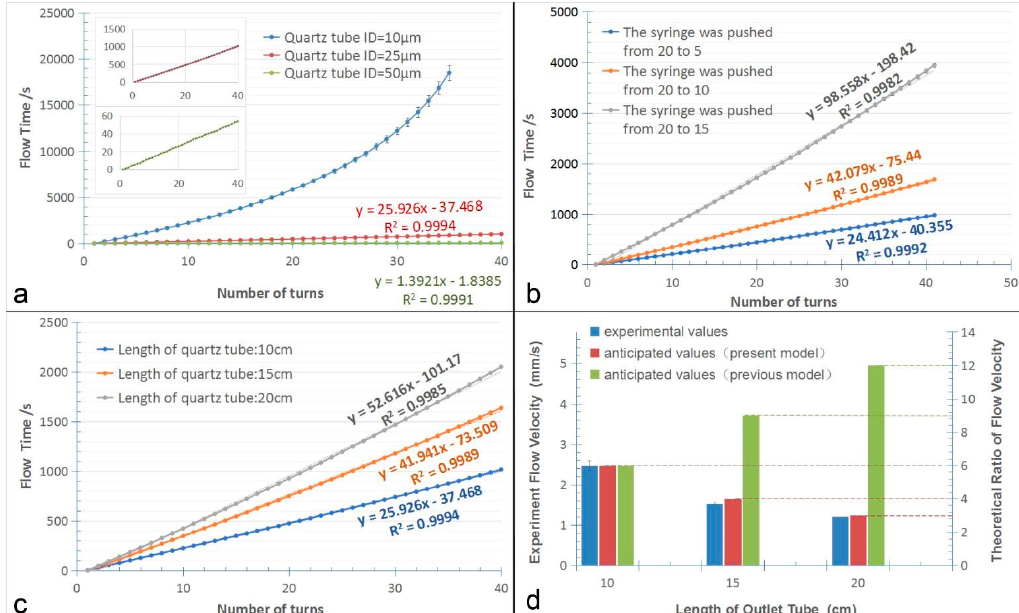
Figure 5. The self-activated flow influenced by ( a ) inner diameter of the tail quartz tube, ( b ) the pressure, and ( c ) the length of the tail quartz tube. ( d ) The relationship between the flow rates and